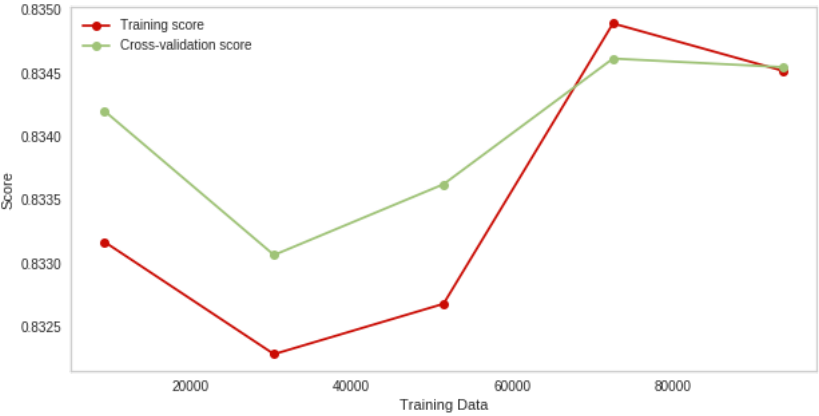
Figure 7. Naive Bayes training learning